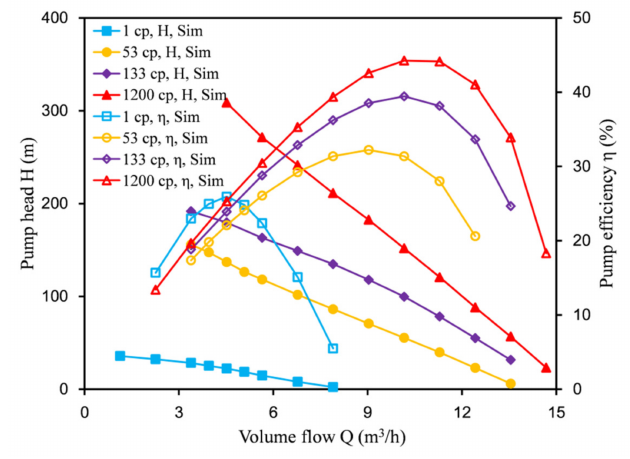
Figure 13. Influence of medium viscosity on the performance of the labyrinth pump.